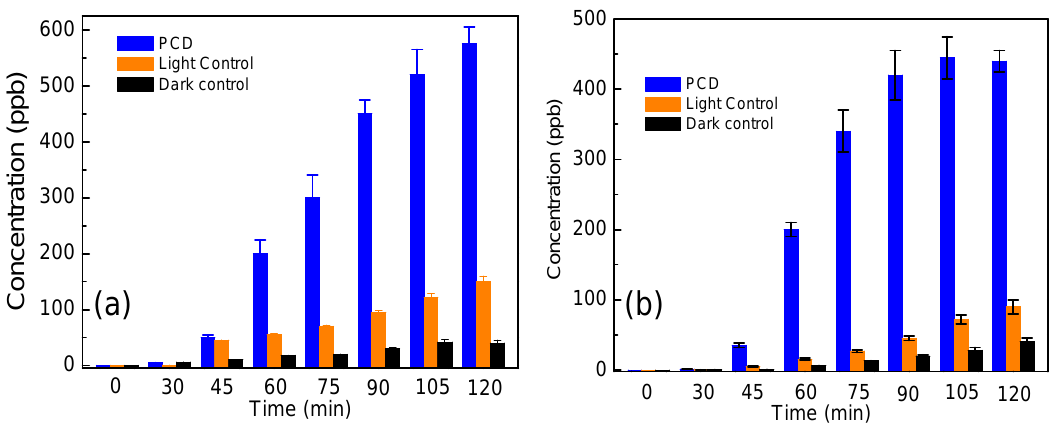
Figure 7. Leakage of K + ion from ( a ) E. coli and ( b ) S. aureus cells subjected to solar-photocatalysis in presence of 2 mg/L and 3 mg/L Ag@ZnO core-shell NPs, respectively. Initial bacteria concentration = 5 × 10 6 CFU/mL, Temperature = 35 ± 2 °C. Error bars indicate the standard deviation of replicates ( n = 3).